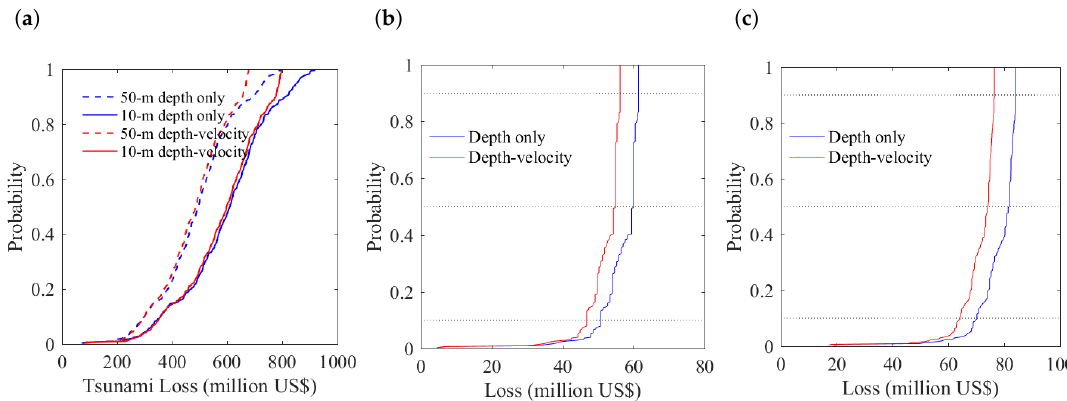
Figure 11. Probabilistic tsunami loss in Onagawa: ( a ) all of Sendai; ( b ) RC in region R2; and ( c ) buildings within 1 km from the coastline.